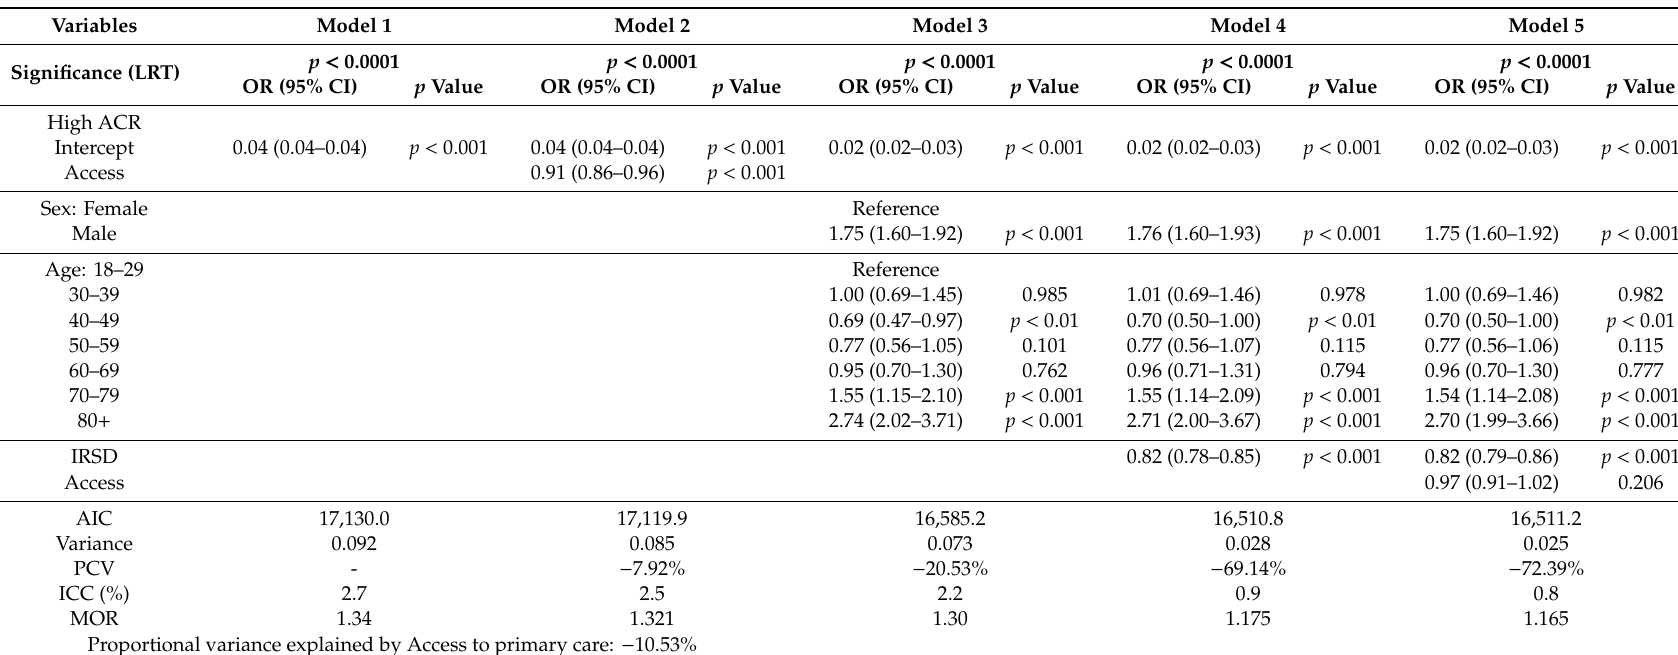
Table 7. Multilevel logistic regression model summaries of high ACR ( ≥ 30 mcg / L to mg /